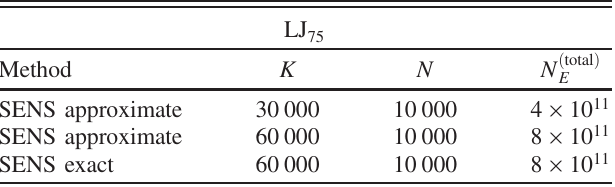
TABLE II. Comparison of methods used to obtain the LJ 75 heat capacity curves shown in Fig. 3. N ð total Þ